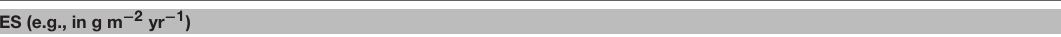
TABLE 1 | Glossary of